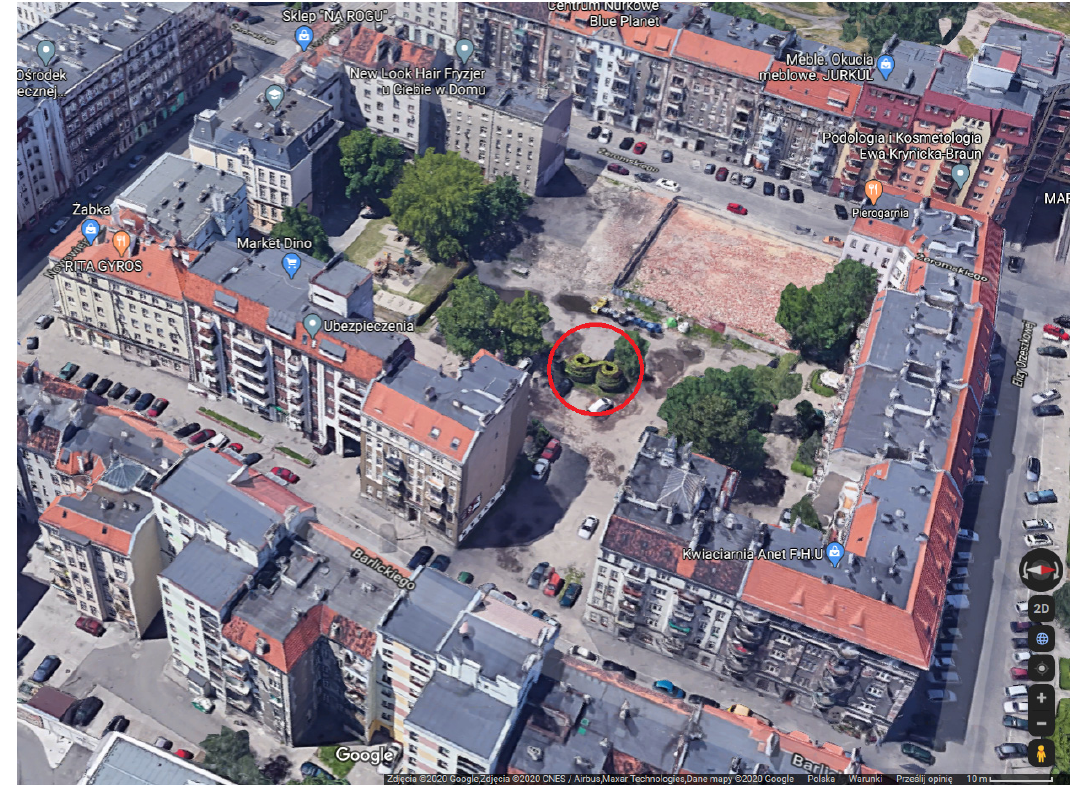
Figure 3. Location and surrounding of the green structure (GS) (red circle), from https://www.google.com/maps.